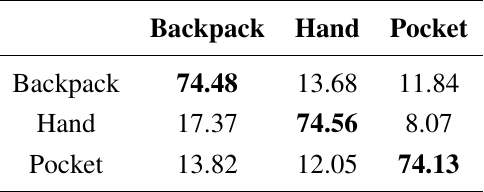
Table 4. Confusion matrices with motion-related features, Dataset 3 (random